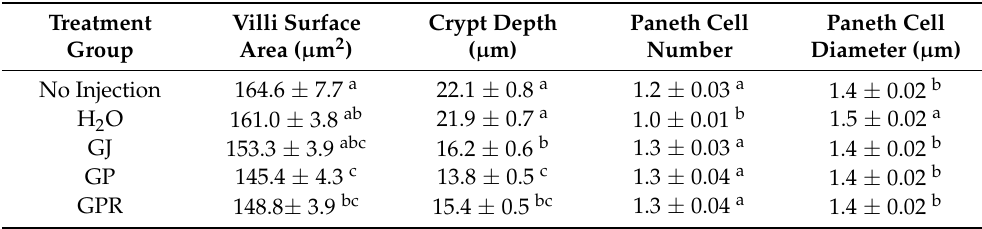
Table 4. Effect of the intra-amniotic administration of grape juice (GJ), pomace (GP), and puree (GPR) on the duodenal villi surface area, crypt depth, Paneth cell number, and diameter.